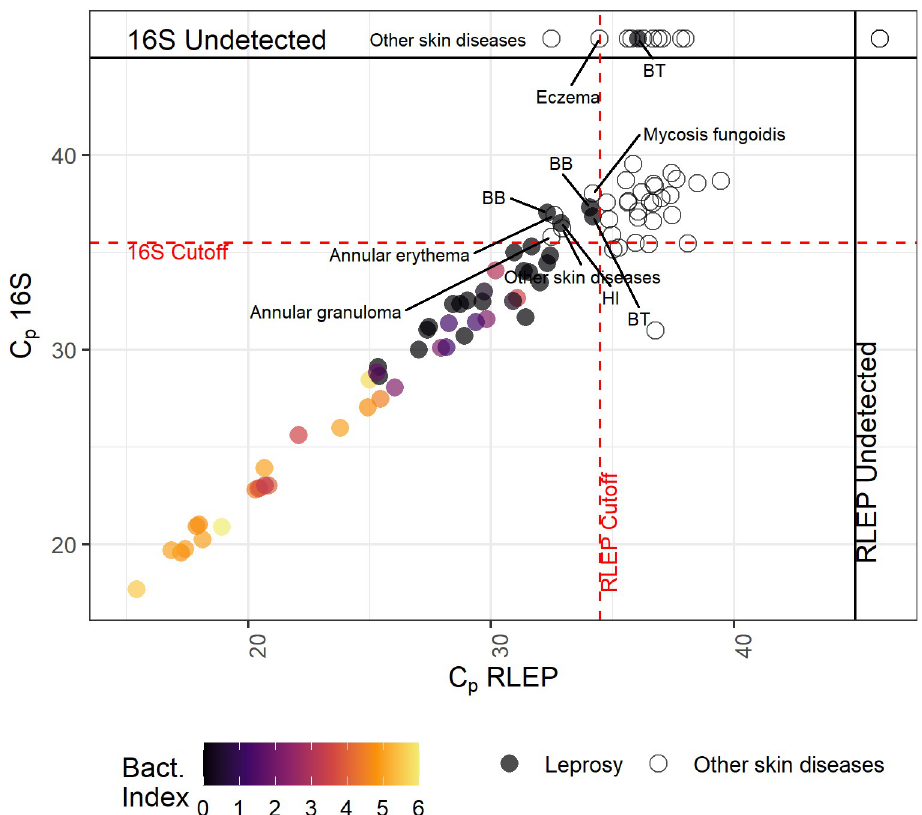
Fig 5. Distribution of C p values obtained for the training panel. Each point represents a different sample (mean C p s of a technical duplicate). Filled circles represent leprosy samples and open dots represent negative samples, as defined by the clinical assessment. Points aligned to the top and right margins indicate samples in which 16S rRNA or RLEP, respectively, were not detected within 45 cycles. Bacterial index is shown as a color gradient (samples for which bacterial index information was not available are filled in gray). Dotted red lines indicate the cutoff values from Table 3. Equivocal or misclassified samples are annotated with the operational classification (false negatives) or with the diagnosis for clinic-negative